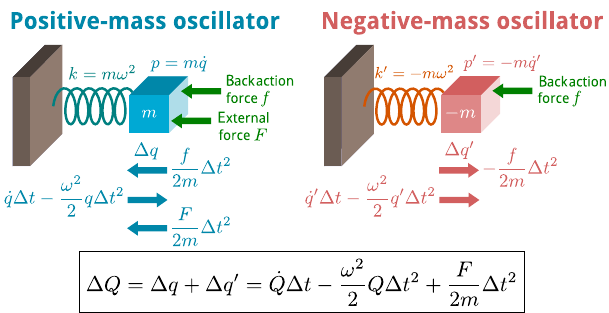
FIG. 2. Given two pairs of canonical variables, f q; p g and f q 0 ; p 0 g , the collective position Q and average momentum P form a conjugate pair, and the relative position (cid:1) and relative momentum (cid:2) form another conjugate pair. The conjugate pairs are restricted by the Heisenberg uncertainty principle. If the unprimed and primed variables are those of a positive-mass and negative-mass oscillator, respectively, however, f Q; (cid:2) g and f (cid:1) ; P g form dynamical oscillator pairs, each of which is a QMFS. Reducing uncertainty in one QMFS at the expense of the other is equivalent to introducing Einstein-Podolsky-Rosen (EPR) correlations among the original oscillator variables.